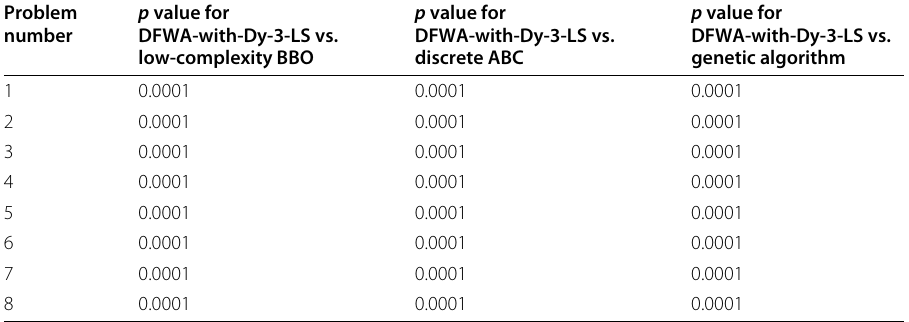
Table 5 T test for the formulated wireless network planning Problem p value for number DFWA-with-Dy-3-LS vs. low-complexity BBO